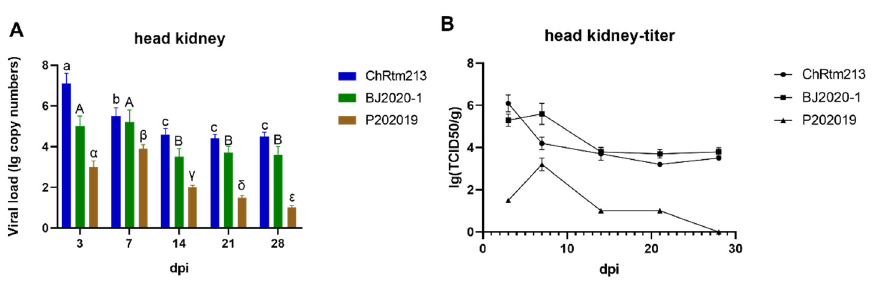
Figure 8. IPNV virus loads in the head kidney were sampled on 3, 7, 14, 21, and 28 dpi. ( A ) Replication kinetics of IPNV-infected rainbow trout. Samples were obtained in triplicate. Total RNA was extracted and analyzed by qPCR. Error bars represent the SD from triplicate within an experiment. Different letters of the same class indicated the statistical significance, p < 0.05. a, b, c indicated that the viral load of IPNV-ChRtm213 was significantly different at different sampling time points, p < 0.05. A, B indicated that the viral load of IPNV-BJ2020-1 was significantly different at different sampling time points, p < 0.05. α , β , γ , δ , ε indicated that the viral load of IPNV-P202019 was significantly different at different sampling time points, p < 0.05. ( B ) The detection of viral titers in the head kidney of IPNV-infected rainbow trout.